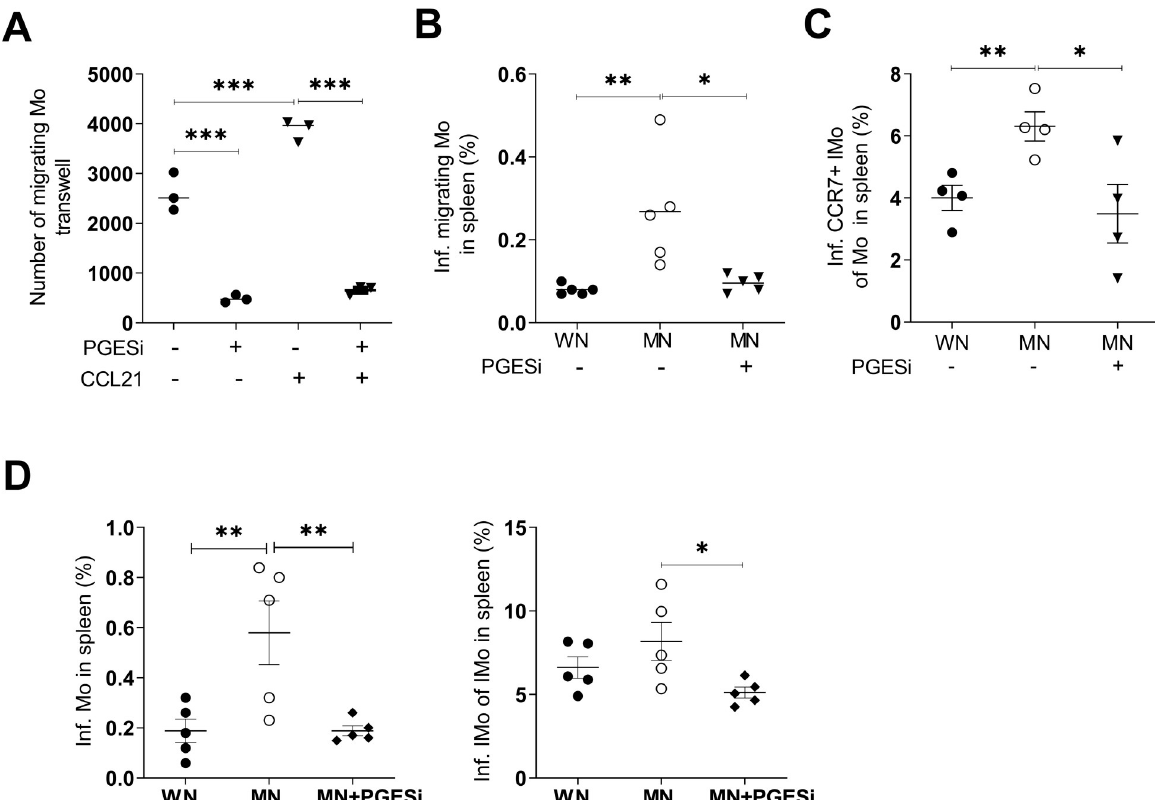
Fig 6. Inhibition of prostaglandin E synthesis blocks the migration of monocytes in malnourished mice. A. Migration of monocytes from L . donovani -infected MN mice with or without treatment with mPGES-1 inhibitor (PGESi, 5mg/kg/IP/day), starting 48h before infection and continuing ex vivo at 5 μ M, with or without exposure to CCL21 gradient (300ng/mL in lower chamber). ��� p < 0.0001 (One-way Anova). Pooled cells from N = 5 mice per group (triplicate). B . Percent of infected skin-derived monocytes in spleen of WN mice and MN mice treated IP with DMSO or MN mice treated with prostaglandin E 2 synthase inhibitor (PGESi) (CAY10526, 5mg/kg/day). � p = 0.01; �� p = 0.08 (One-way Anova). N = 5 mice per group. C. Percent of infected CCR7+ inflammatory monocytes in the spleen of WN mice and MN mice treated with DMSO or MN mice treated with PGESi inhibitor. Determined at 48h p.i. by flow cytometry. �� p = 0.0098 (Unpaired t-test); � p = 0.037 (One-way Anova). N = 4 mice per group. D. Percent of infected monocytes (Left panel) and proportion of infected inflammatory monocytes of inflammatory monocytes (Right panel) of WN mice, and MN mice treated IP with DMSO (MN) or prostaglandin E synthase inhibitor (MN + PGESi, CAY10526, 5mg/kg/ day/IP) starting 48 hr before infection. Evaluated at 48h p.i. by flow cytometry. �� p = 0.01, � p = 0.04 (One-way Anova). N = 5 mice per group.